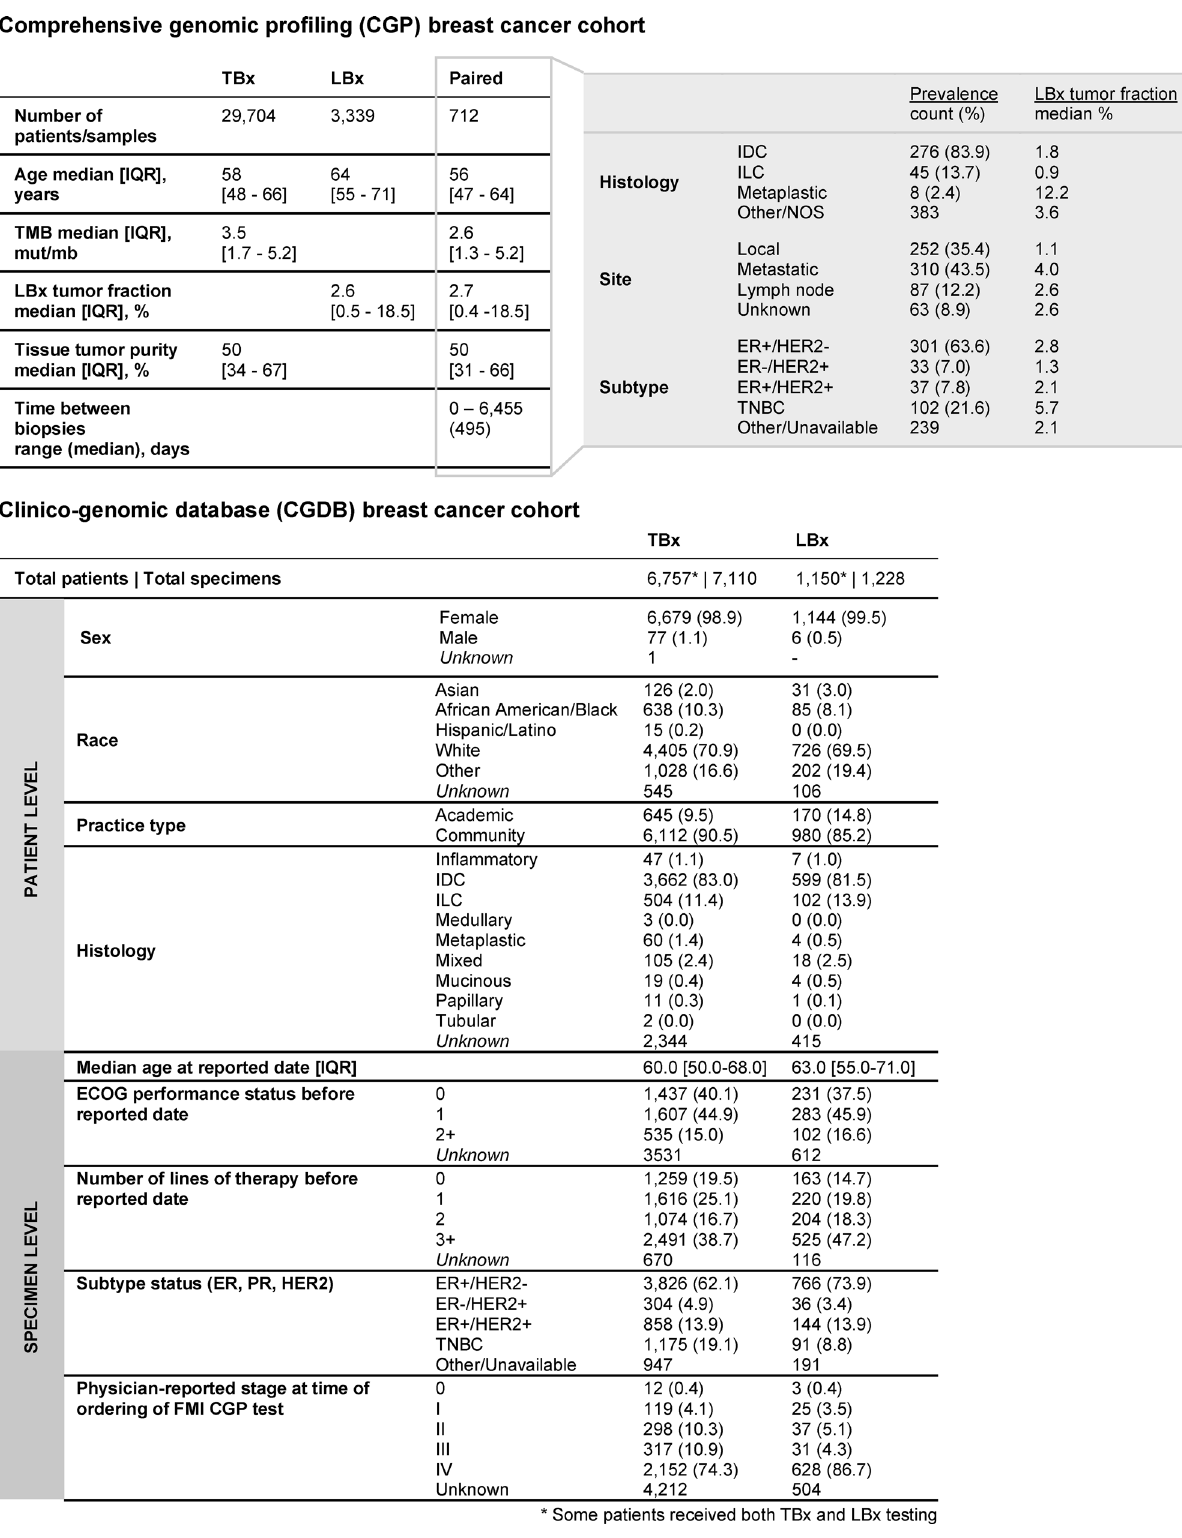
Fig. 2 | Overview of the study cohort and patient characteristics. This study cohort comprised patients who received comprehensive genomic pro fi ling (CGP) as part of routine clinical care (top). A total of 29,704 patients with tissue biopsy (TBx)-based CGP, 3339 patients with liquid biopsy (LBx)-based CGP and 712 patientswithlongitudinalTBxandLBxCGPwereexamined.Patientandspecimen- level characteristics have been provided for each of these cohorts. Additional breakdown of histological subtype, site of biopsy and receptor subtype informa- tionisprovidedforthe712patientswithlongitudinalTBxandLBxCGP.Treatment